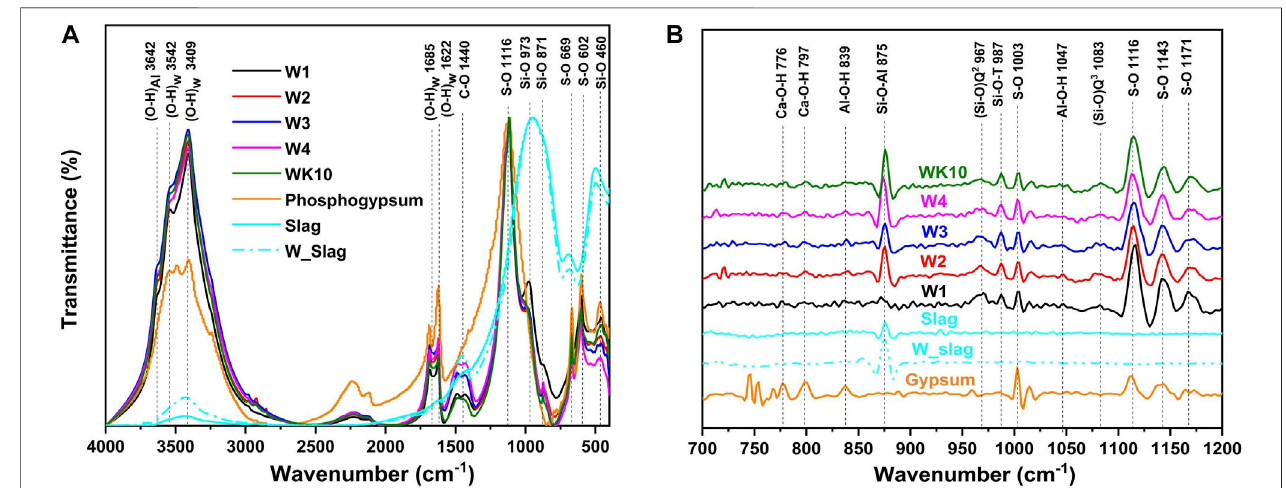
FIGURE7| FTIRspectraofP-SSCbinders at28 days,slag,andphosphogypsum; (A) transmittance(T) vs .wavelength(W); (B) 2 nd derivative ofthetransmittance d 2 T/dW 2 vs. wavelength.